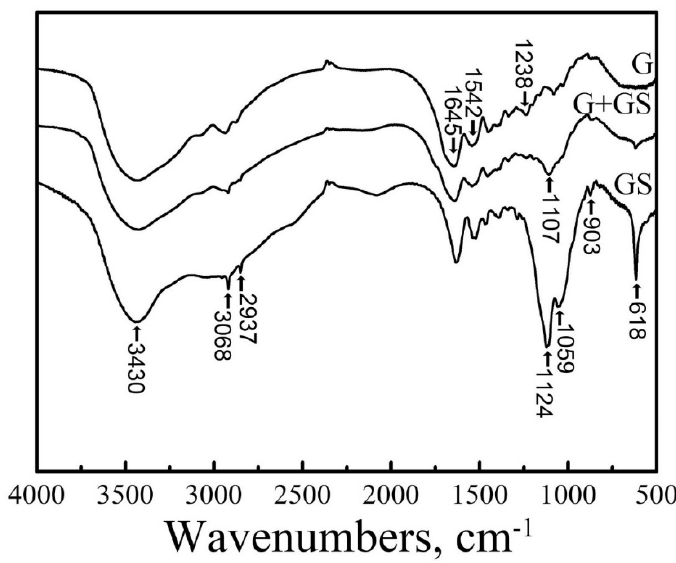
Figure 14. FTIR analysis results of the gelatin, GS and GS-loaded gelatin [65] . Reprinted with per- mission from ref. [67] . Reprinted with permission from ref. [67] . © 2021 Elsevier.